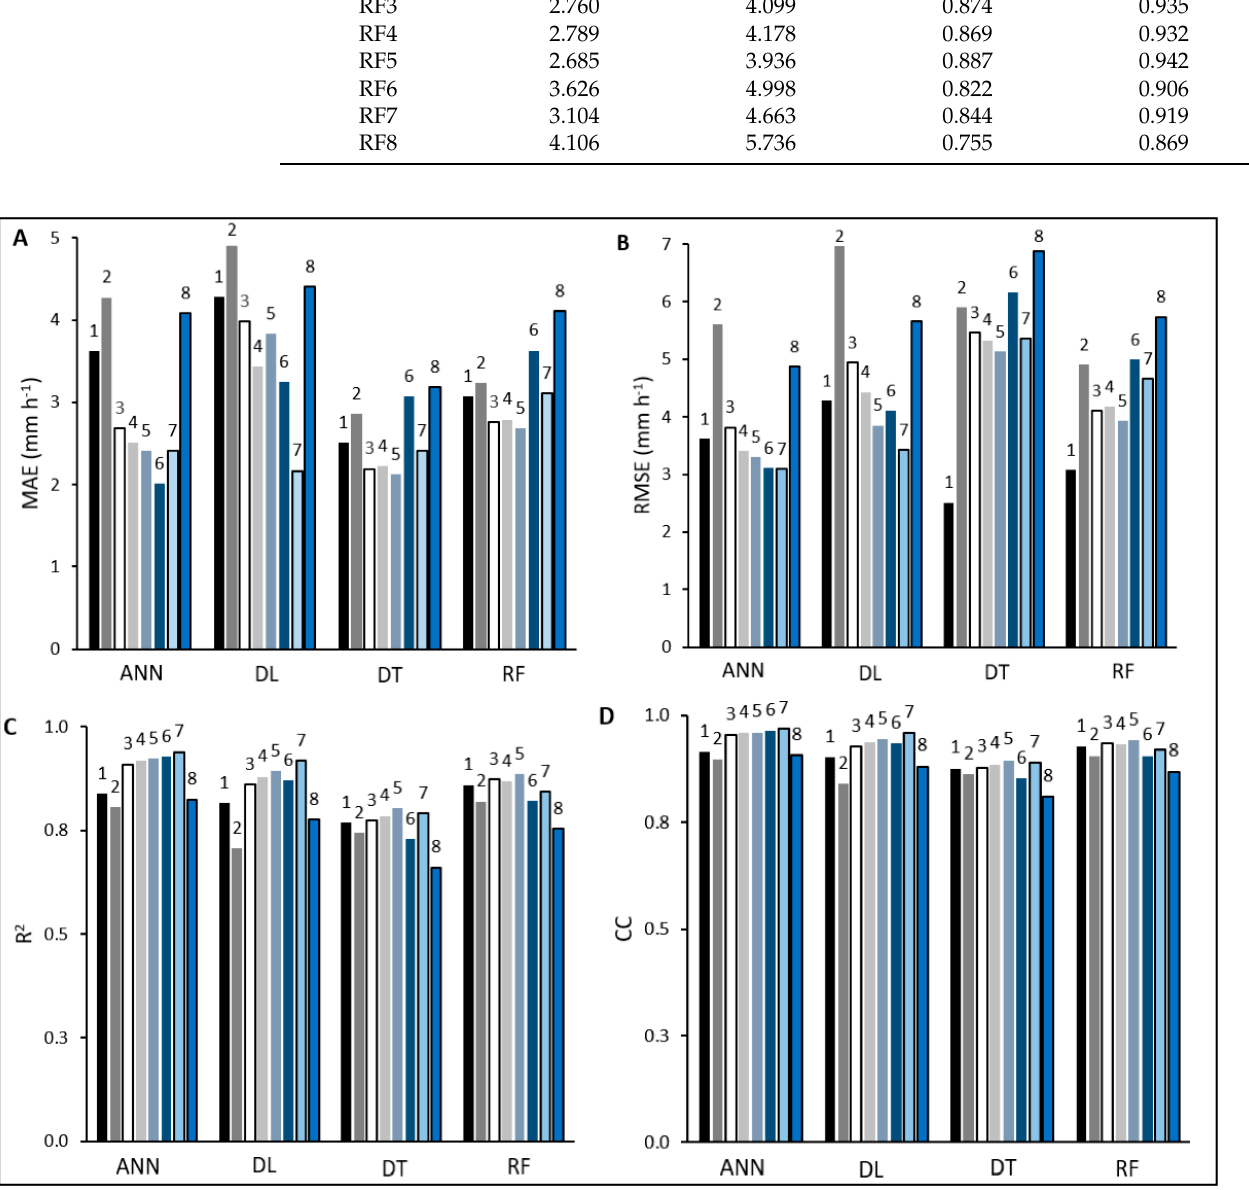
Figure 4. Performance metrics of machine learning models with eight combinations of soil input data.